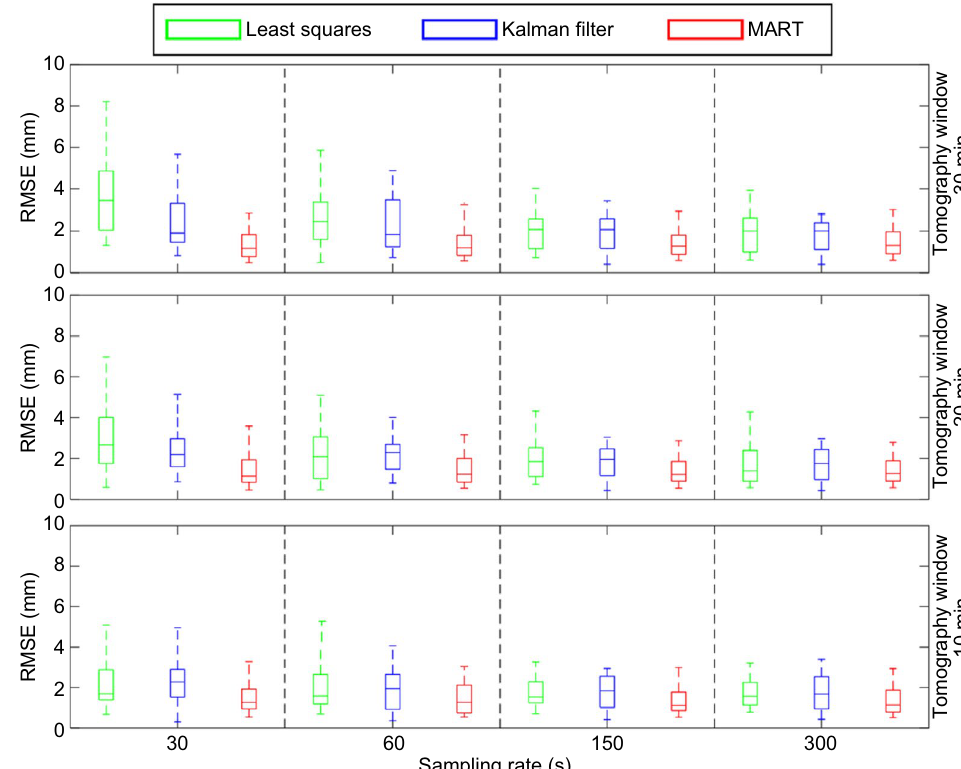
Fig. 5 Boxplot of the SWV RMSEs in three types of methods for different schemes during the experimental